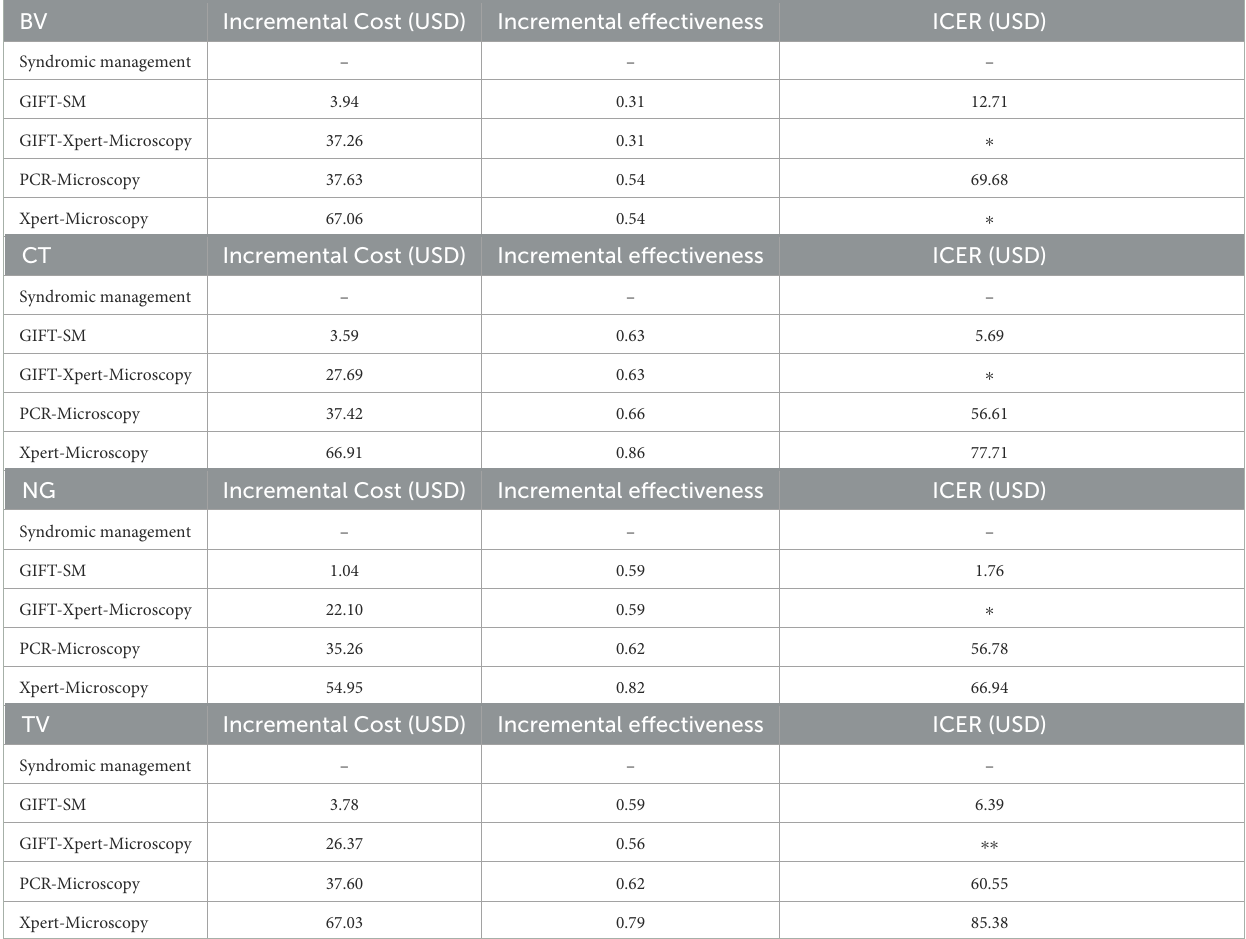
TABLE 6 Results from separated decision trees in 2019